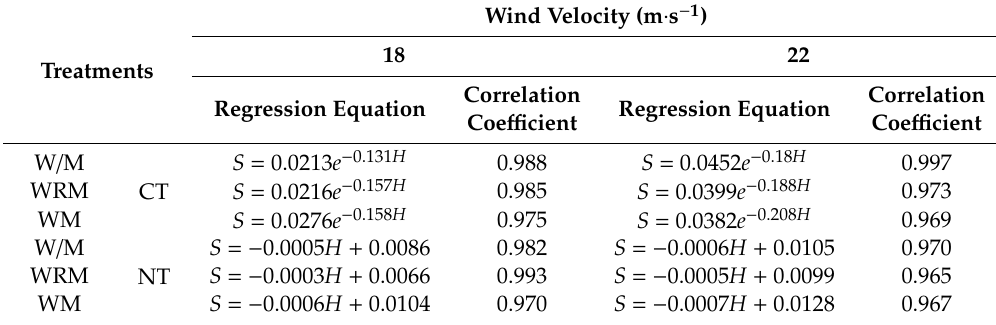
Table 4. Relationship between sand transport rate ( S ) and above the soil surface ( H ) as a ff ected by cropping system, tillage method, and wind velocity during two